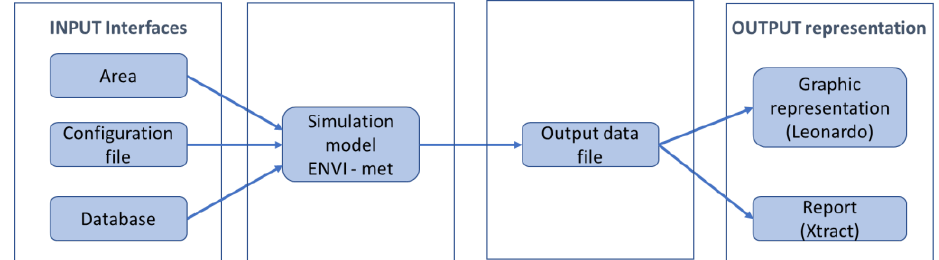
Figure 9. ENVI-Met layers.